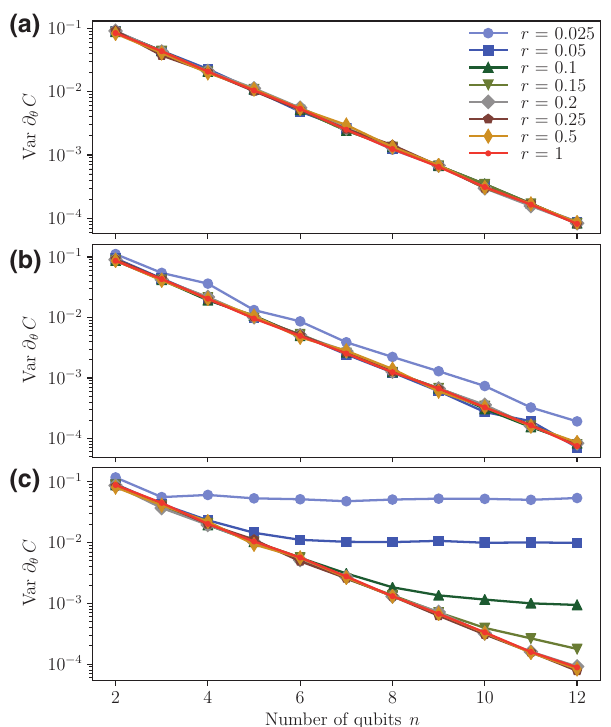
FIG. 4. Partial-derivative scalings for restricted angle ranges. The scaling of the variance in the partial derivative when the rota- + 2 π r ], are randomly chosen from the range [ ˜ θ i , ˜ θ i tion angles θ i l l l such that for r = 1 (red) the ansatz explores the entire solution space but for r (cid:16) 1 (blue) the ansatz is constrained to exploring } . In (a), the angles close to the initialization point defined by { ˜ θ i l } are a fixed (randomly chosen) initialization point away from { ˜ θ i l the solution (here, we consider a local cost but the data for a global cost are essentially unchanged). In (b) and (c), which cor- = 0 respond to global and local costs, respectively, the angles ˜ θ i l for all l and i , which is close to the global minimum of the cost. , the rotation In all cases, the derivative is taken with respect to θ 1 1 angle of the first qubit in the first layer, and the variance is taken over an ensemble of 1000 unitaries.